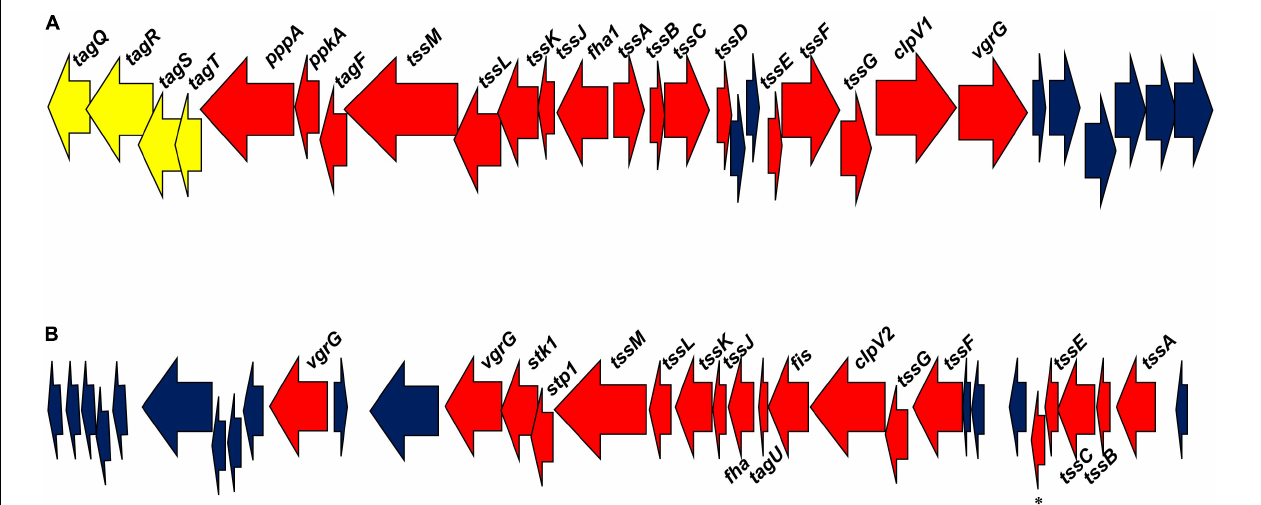
FIGURE 1 | Pseudomonas chlororaphis 30–84 T6SS gene clusters. (A) The T6SS-1 cluster of genes. (B) The T6SS-2 cluster of genes. Red arrows designate genes encoding conserved proteins involved in T6SS structure and function. Blue arrows designate genes encoding hypothetical proteins. Yellow arrows designate genes encoding proteins associated with the TagQRST system in T6SS-1. *Refers to a gene encoding a T6SS protein with a PAAR